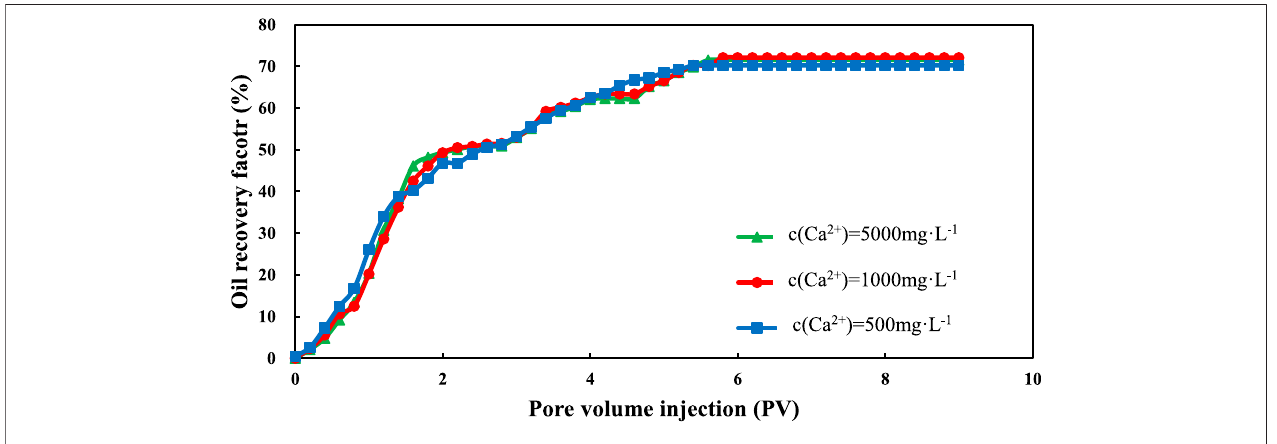
FIGURE 10 | Oil recovery of quartz sand packs displaced by different salinity of CaCl 2 .